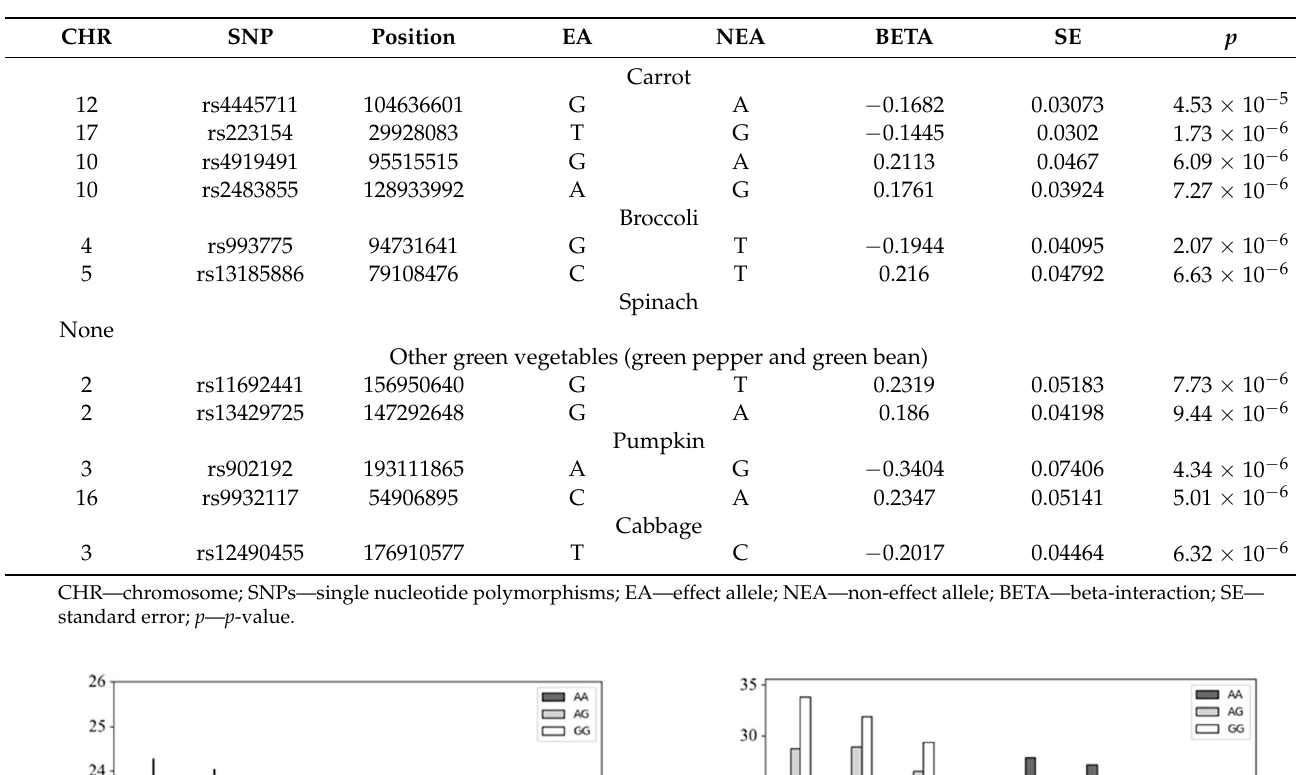
Table 2. SNPs with suggestive levels of association ( p < 1 × 10 − 5 ) with body mass index.